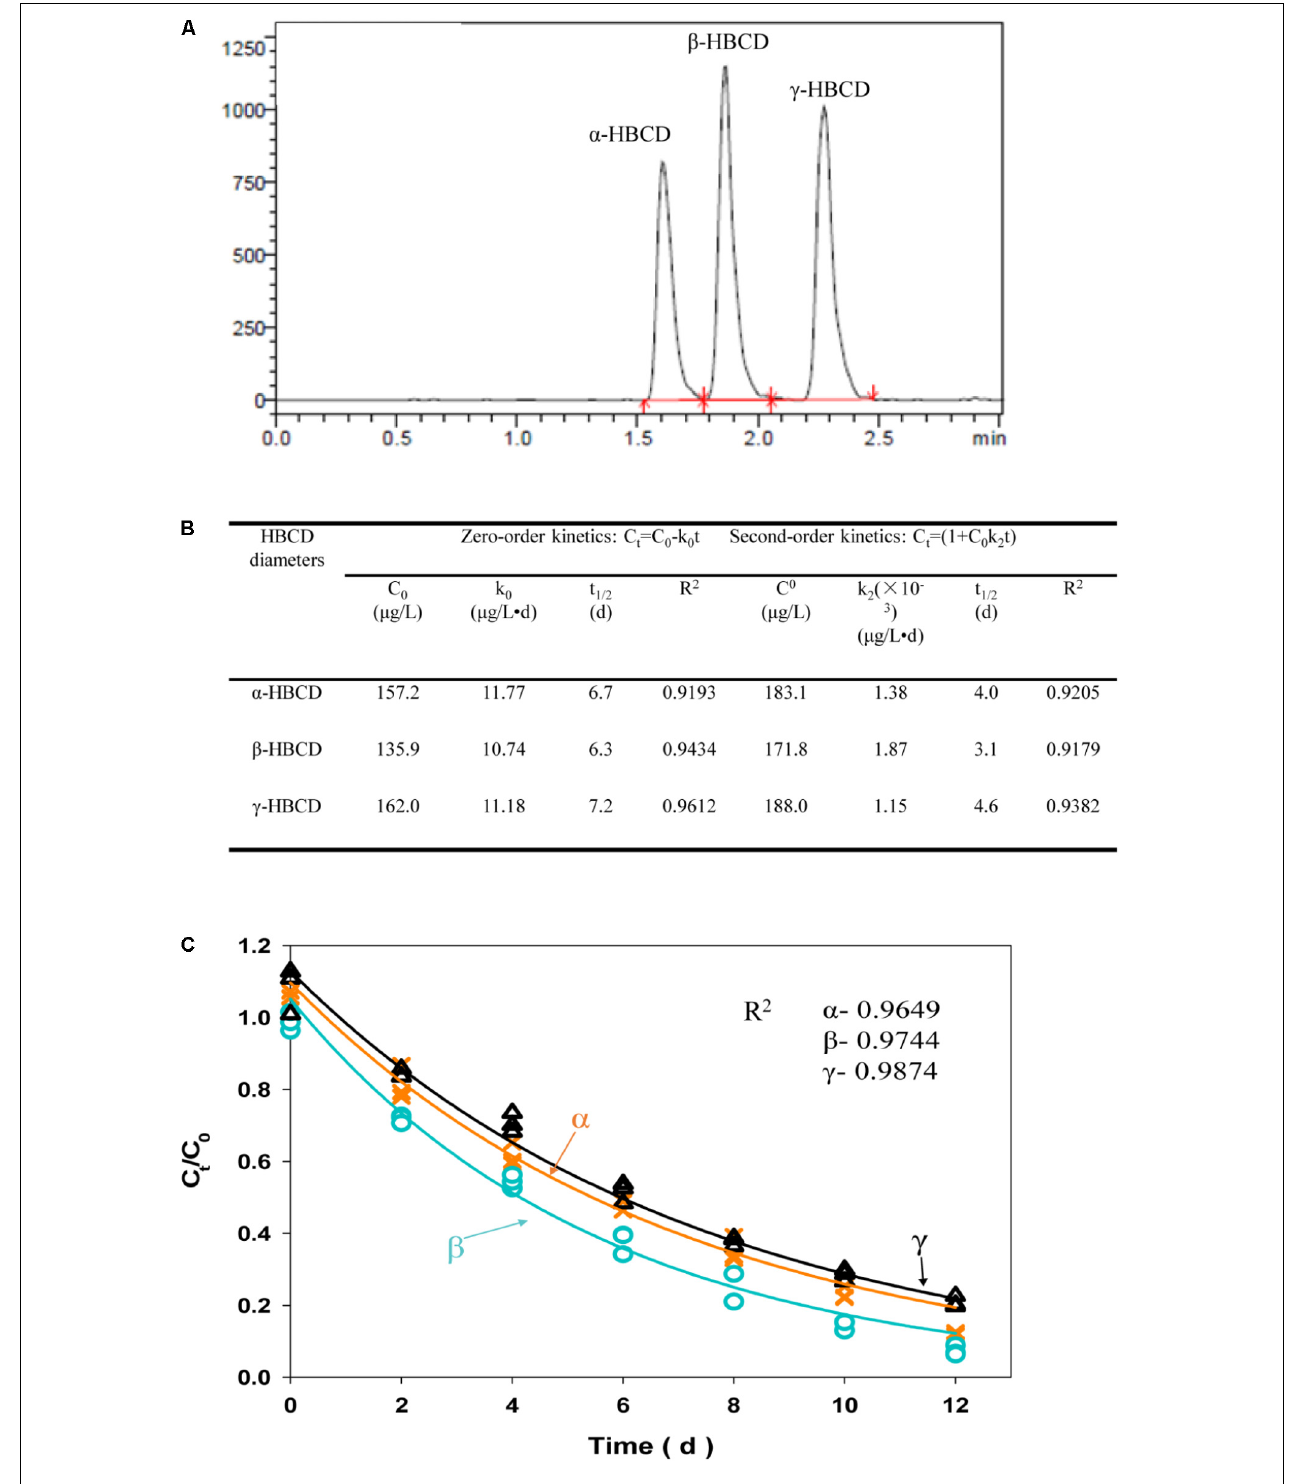
FIGURE 3 | LC/MS/MS chromatograms of three HBCD diastereomers, including α -HBCD, β -HBCD, and γ -HBCD (A) . Degradation of individual HBCD diastereomers fitted the zero- and second-order model (B) . Degradation of individual HBCD diastereomers was fitted the first-order model (C) . The solid lines represent the predicted first-order decay curve deduced from the experimental data. The R 2 -value represents the coefficient for each HBCD diastereomers degradation model prediction